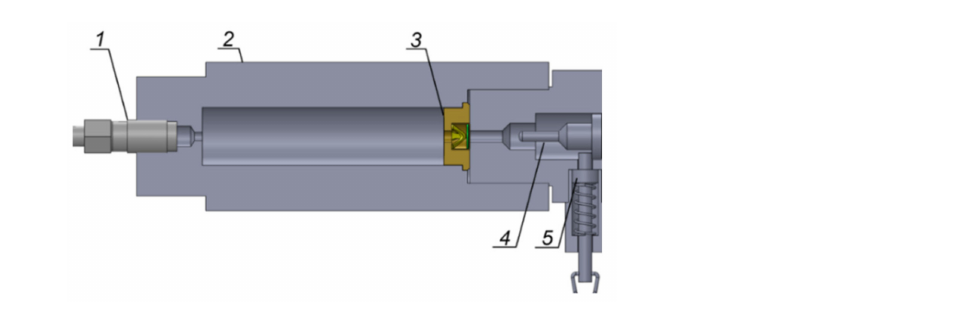
Figure 1. The experimental setup: 1—pressure gauge, 2—chamber, 3—primer, 4—firing pin, 5—pin catch. The chamber had a capacity of 17.5 cm 3 , equal to the capacity of the cartridge case of 12.7 × 99 mm ammunition with an M33 Ball projectile, produced by MESKO SA (the volume of the projectile bottom was taken into account). The dimensions of the chamber are presented in Figure 2.